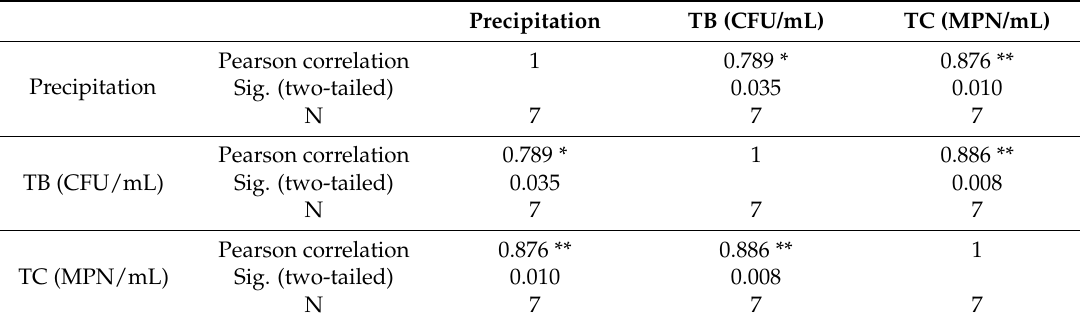
Table 4. Correlation analysis results between precipitation, TB, and TC.